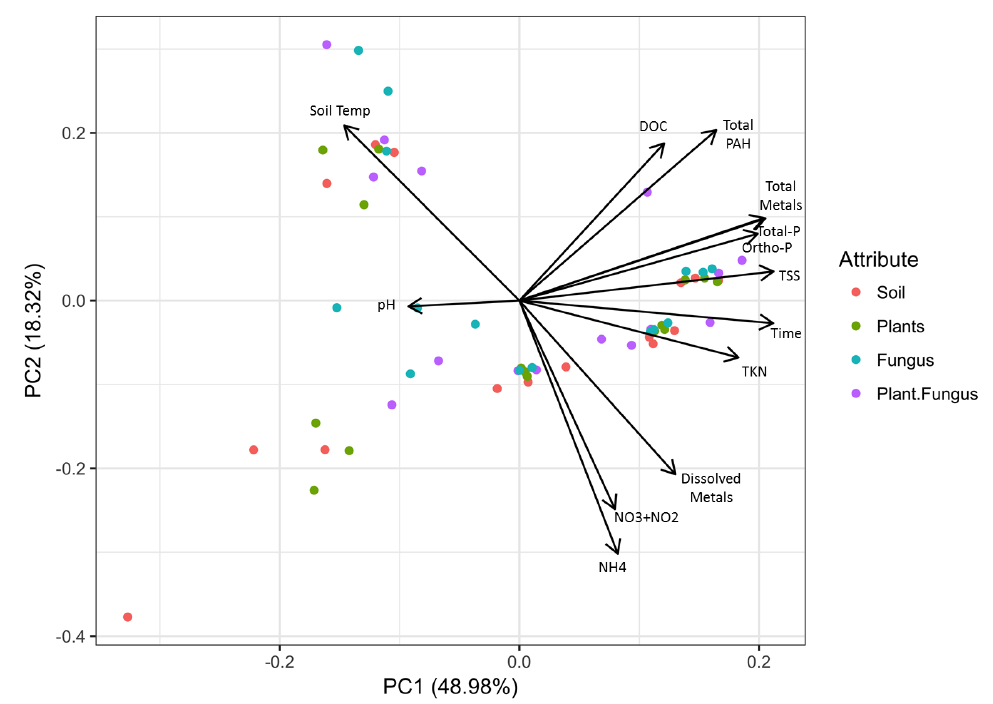
Figure 7. Principle component analysis biplot describing 67% of water quality parameter variance. The observations (colored by attribute) and factor loadings of ten water quality response and three continuous explanatory variables tend to group by time, soil temperature, pH, and TSS.